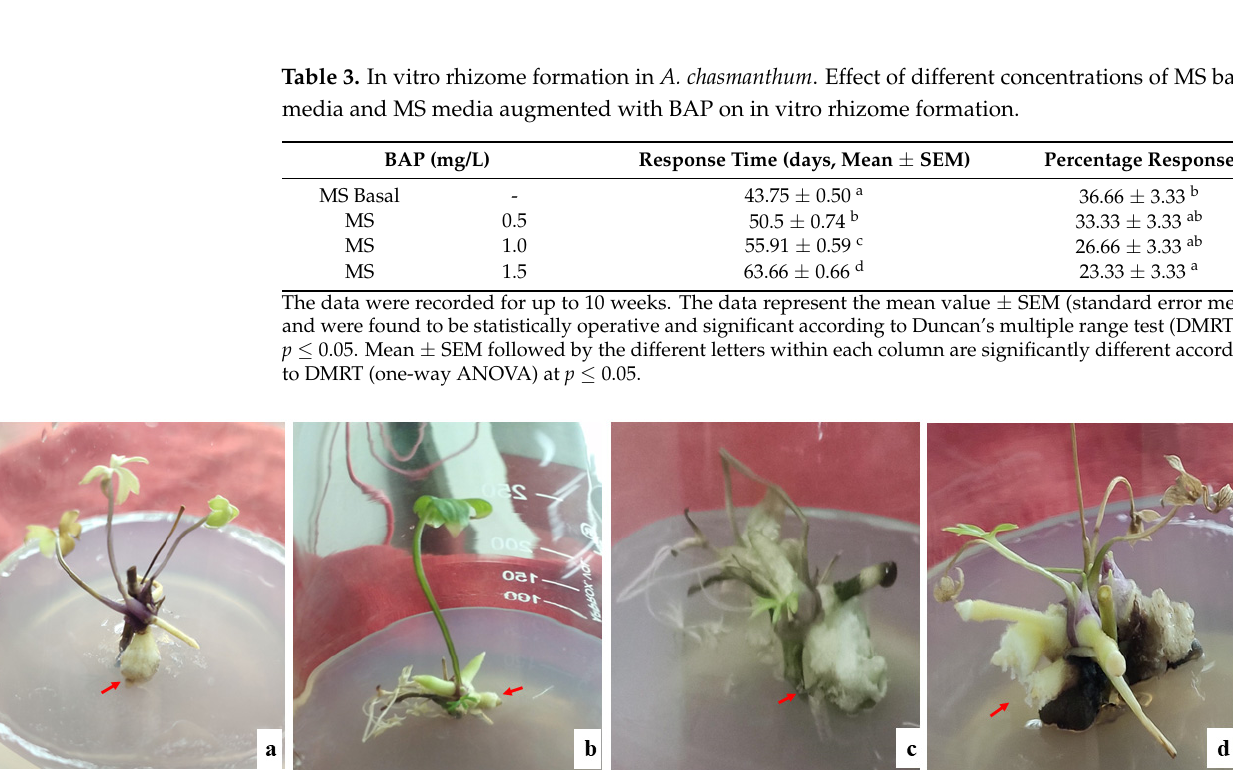
Figure 3. In vitro rhizome formation in Aconitum chasmanthum Stapf ex Holmes: ( a ) in vitro rhizome formation in MS Basal media; ( b ) in vitro rhizome formation in MS media supplemented with BAP (0.5 mg/L); ( c ) in vitro rhizome formation in MS media supplemented with BAP (1.0 mg/L); ( d ) in vitro rhizome formation in MS media supplemented with BAP (1.5 mg/L).